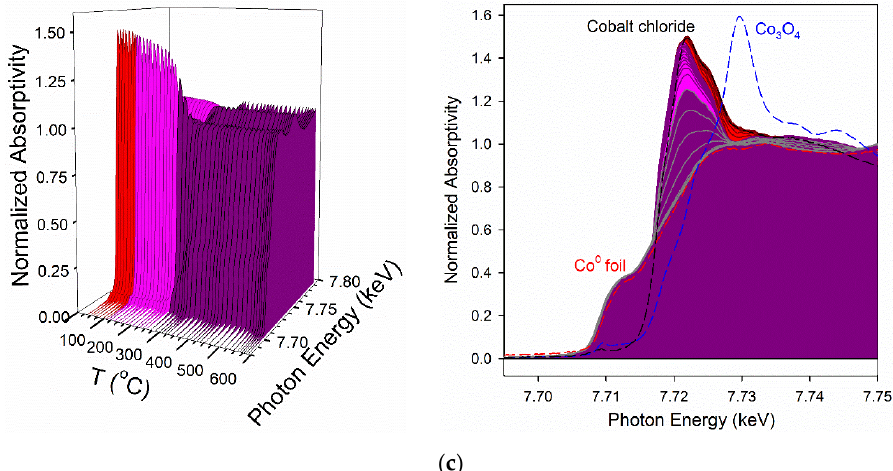
Figure 12. TPR-XANES profiles of ( a ) calcined 12% Co/SiO 2 from cobalt chloride, ( b ) uncalcined 12% Co/SiO 2 from cobalt chloride, and ( c ) uncalcined 0.5% Pt-12% Co/SiO 2 from cobalt chloride.